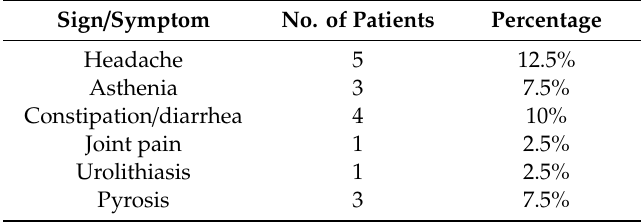
Table 5. Adverse e ff ects during the consumption of a very low calorie ketogenic diet. Sign / Symptom No. of Patients Percentage Headache 5 12.5% Asthenia 3 7.5% Constipation / diarrhea 10% Joint pain 2.5% Urolithiasis 2.5% Pyrosis